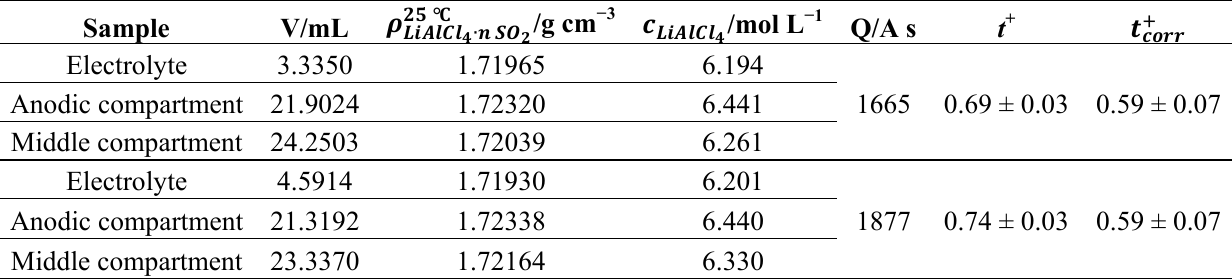
Table 1. Results of Hittorf